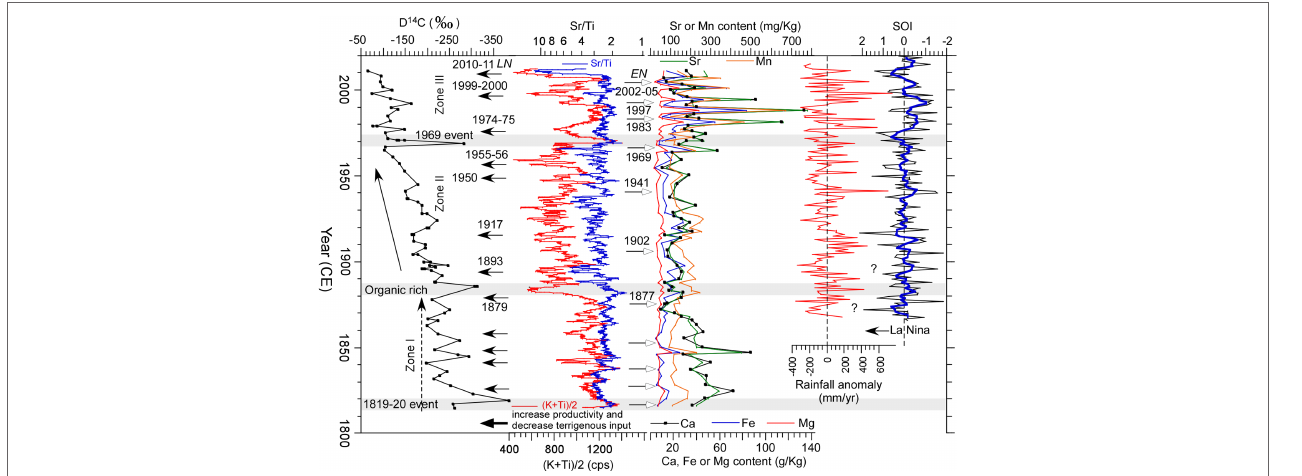
FIGURE 9 | Comparisons of the D 14 C, scanning XRF elemental content, ICP-OES measured acid-leachable elemental concentration with the historical rainfall (the data was downloaded from https://www.santabarbaraca.gov/SBdocuments/Advisory_Groups/Water_Commission before it was removed.) and SOI records. The open head arrows refer El Niño events, and the solid head arrows reflect La Niña events. Note that the relationship between the rainfall in southern California and ENSO events is not fixed. For example, negative SOI values around late 1890s (shown by a question mark there) did not result in high rainfalls. Another question mark around 1870 shows the comparison is not valid, because low rainfall during this La Niña event would lead to high ALE contents but low scanning XRF siliciclastic elemental contents. This outliner may be caused by chronological